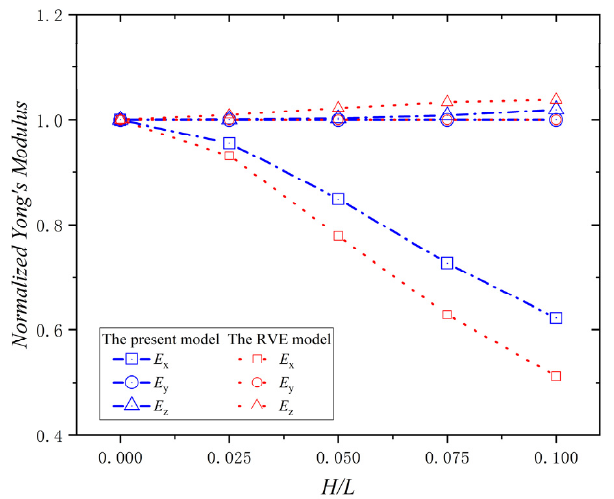
Figure 9. Normalized Young’s modulus vs. ply wrinkle parameter 𝐻 / 𝐿; 𝜑 = 30°.